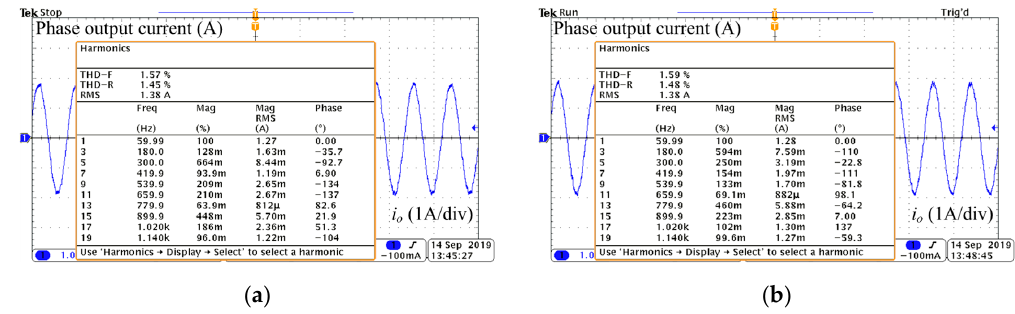
( a ) without switching loss balancing control; ( b ) with switching loss balancing control.